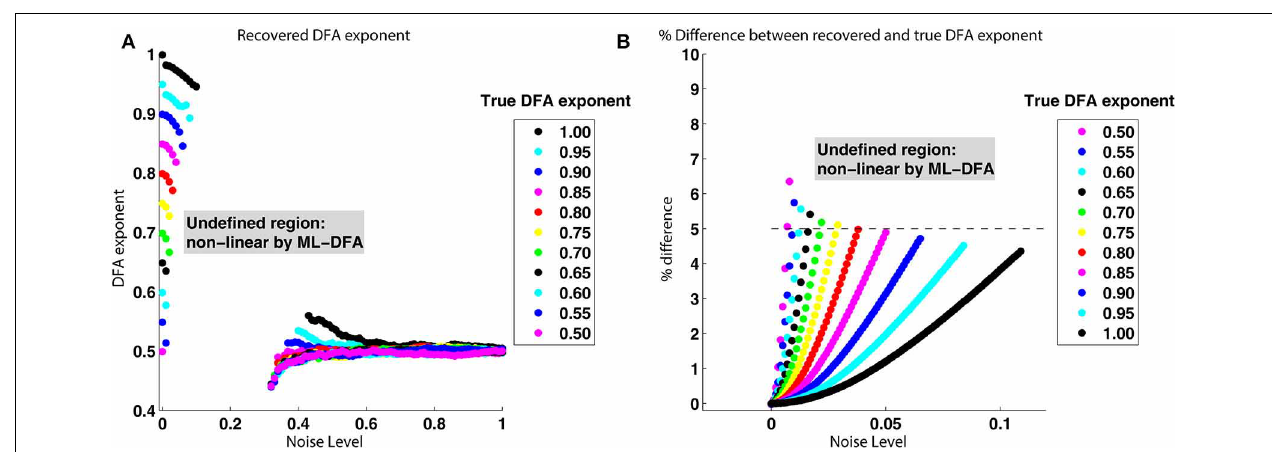
FIGURE 6 | True and recovered DFA exponents for noisy signals with LRTCs. (A) Recovered DFA exponent values as noise is progressively added. For each of the DFA exponents given in the legend (box insert), a signal x (cid:5) 1 ( t ) was constructed with a noise level σ ∈ [ 0 , 1 ] , shown on the x axis. The phase synchrony analysis method was applied to x